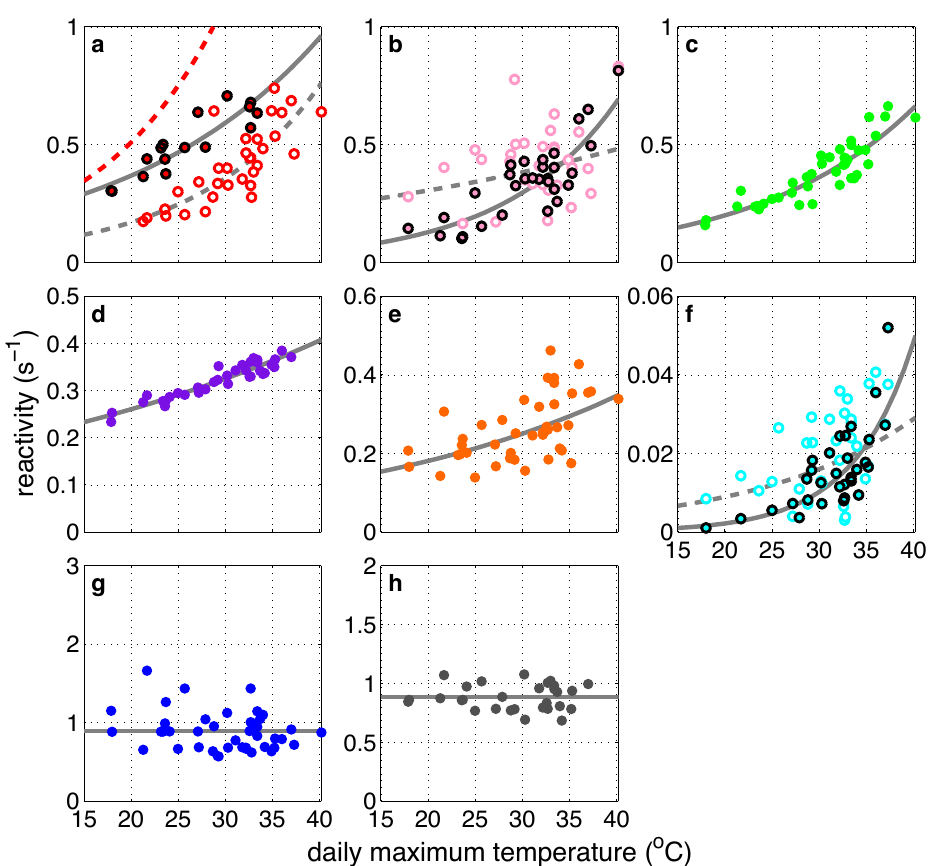
Fig. B1. Daily average 6 i VOCR i (s − 1 ) versus the daily maximum temperature ( ◦ C) for (a) H 2 CO (closed circles with black outline) and calculated acetaldehyde (open circles), (b) methanol (closed circles with black outline) and ethanol (open circles), c) known biogenic VOCs, (d) CH 4 , (e) temperature-dependent alkanes, (f) formic acid (closed circles with black outline) and acetic acid (open circles), (g) all temperature-independent AVOCs, and (h) CO. Gray solid and dashed lines are empirically derived exponential fits for (a–f) . The solid lines in (a, b, f) are fits to the C 1 molecules; the dashed lines are fits to the C 2 molecules. In (g) and (h) , gray lines are means. Acetaldehyde, MVK, ethane, and benzene are estimated (see Appendix B for details), otherwise VOCR i are derived from measured concentrations. In (a) , the red dashed line shows the fit to the acetaldehyde computed from steady-state relationships, as discussed in Appendix